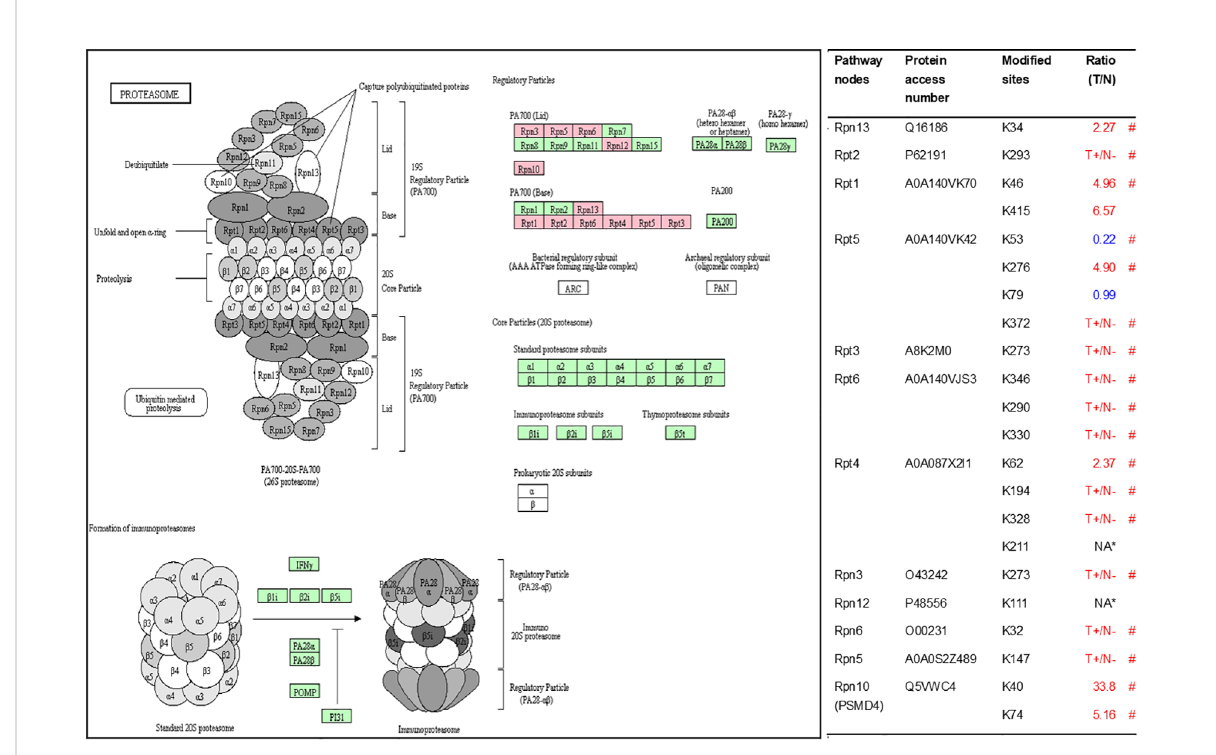
FIGURE 10 Ubiquitination-mediated proteasome pathway. Pink=the identi fi ed ubiquitinated subunits. Green = non-ubiquitinated subunits. K* = ubiquitinated lysine residue. Red indicates the degree of ubiquitination of this site is upregulated, and blue indicates downregulated. Ratio(T/N) = Ratio of tumor to control. T+/N- = ubiquitination only in tumor. NA* means no quantitative information in both tumor and control. # means statistically signi fi cantly altered ubiquitination level in tumor compared to controls.